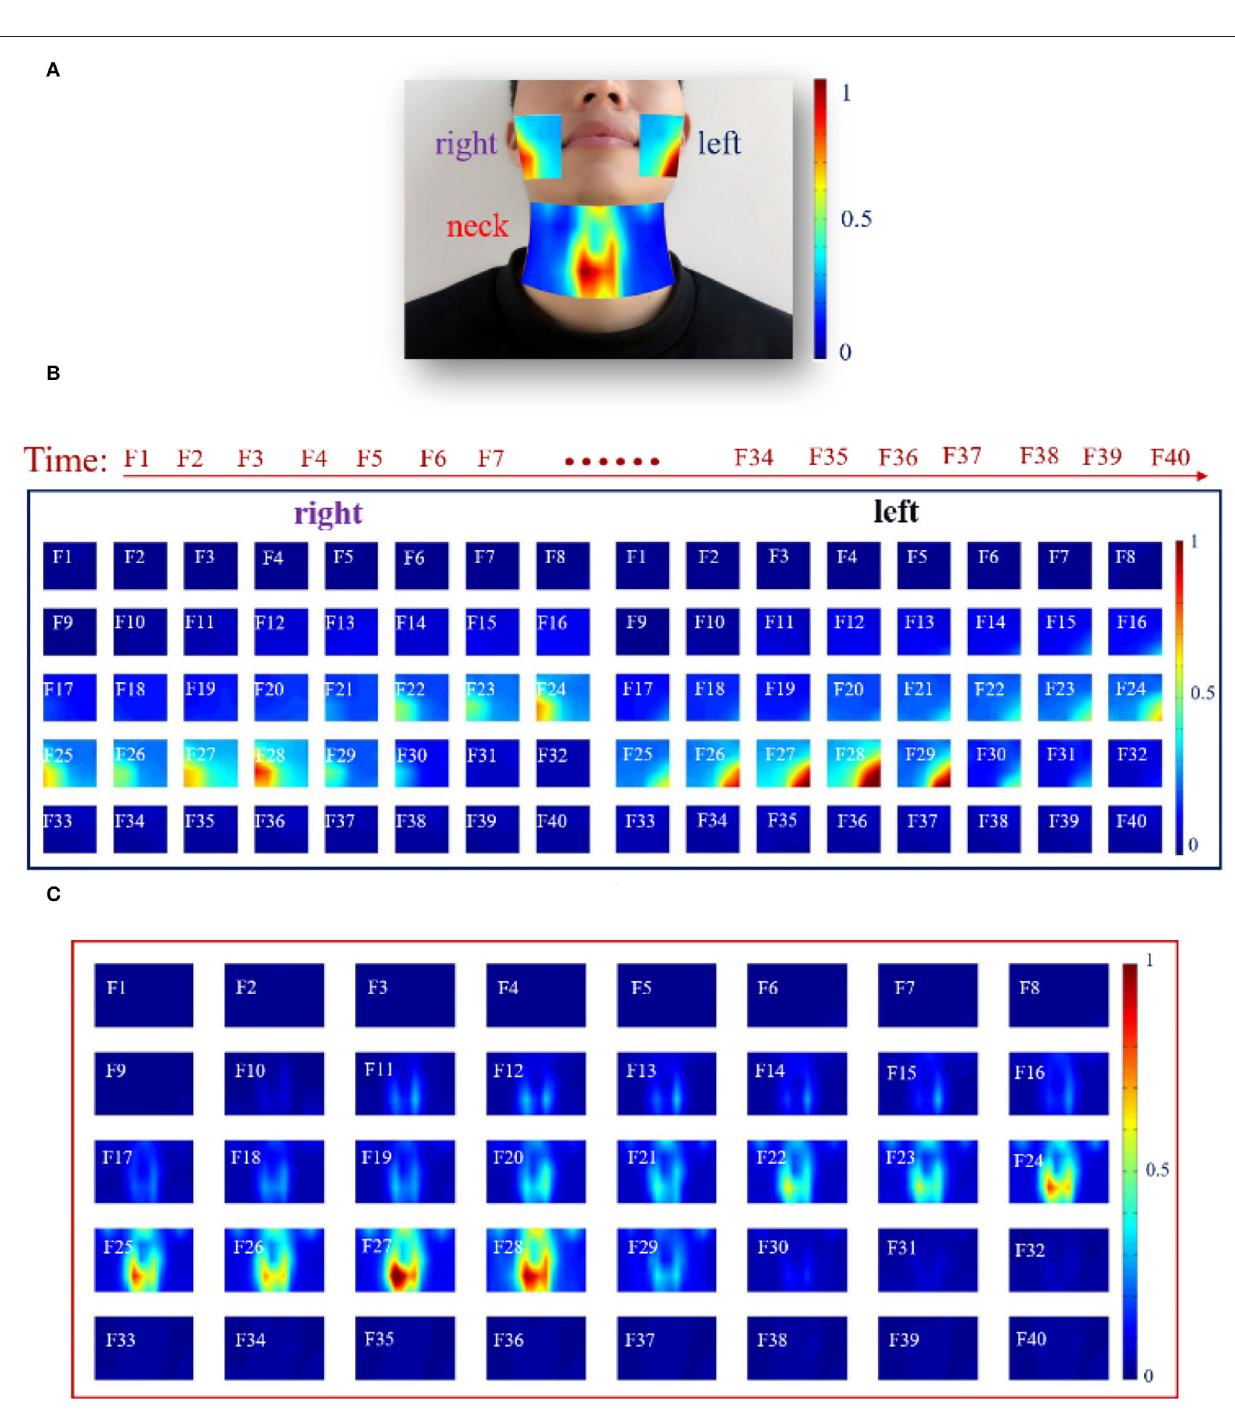
FIGURE 5 | The HD sEMG energy maps of the facial and neck muscles by using 40 analysis windows with a length of 250ms during phonating vowel [a:] with pitch increase: (A) A typical frame of HD sEMG energy map visualizing the facial and neck muscle activities; (B) HD energy maps of the facial muscles; (C) HD energy maps of the neck